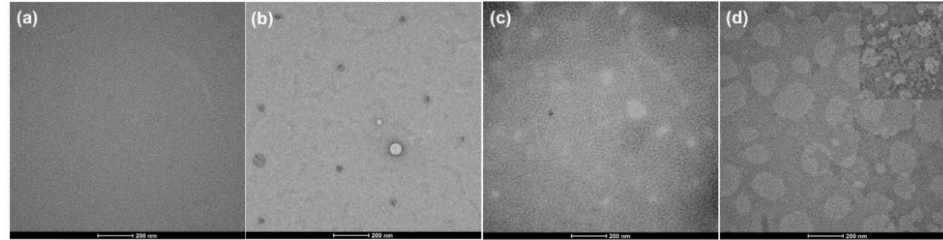
Figure 5. FE-TEM images of the copolymer membranes with various loading of PDMS: ( a ) 6FDA-CE- PI, ( b ) CE-PDMS-2.5, ( c ) CE-PDMS-5, and ( d ) CE-PDMS-10; inset image for CE-PDMS-10 copolymer membrane shows severe